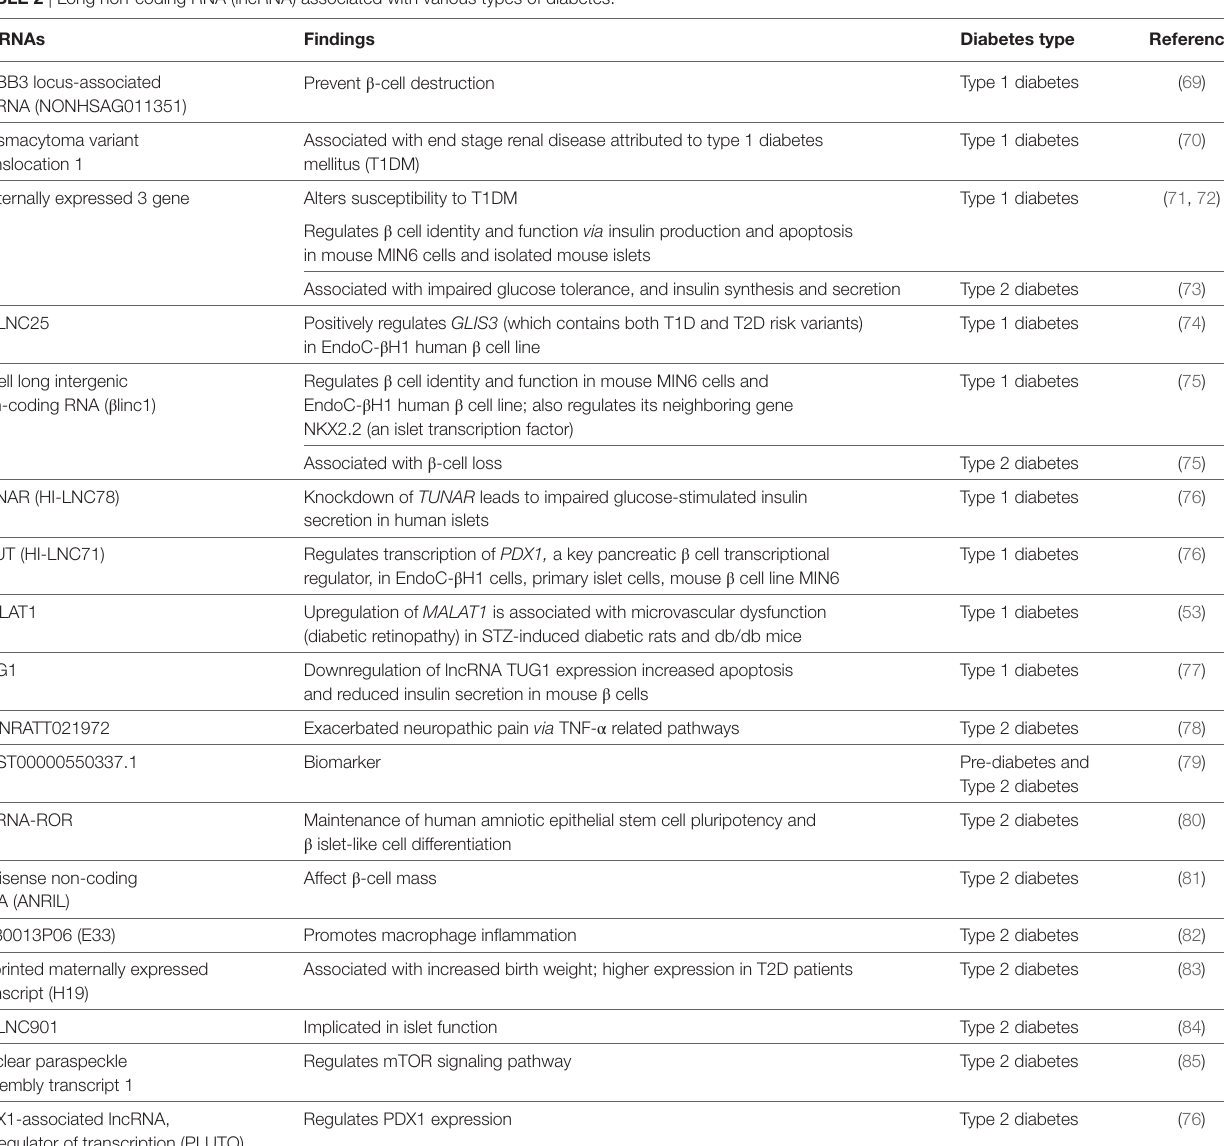
TABLe 2 | Long non-coding RNA (lncRNA) associated with various types of diabetes.